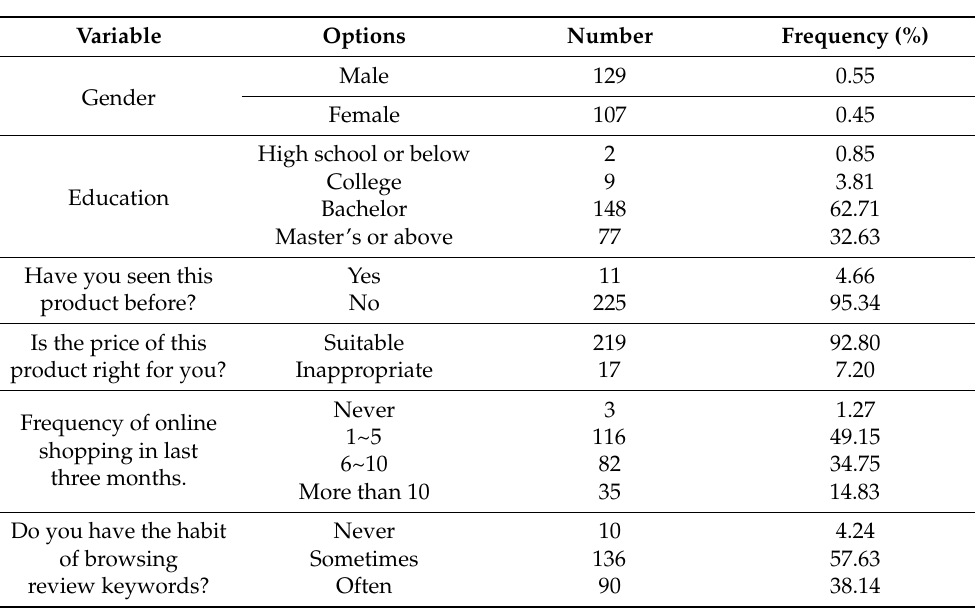
Table 7. Descriptive statistics of the